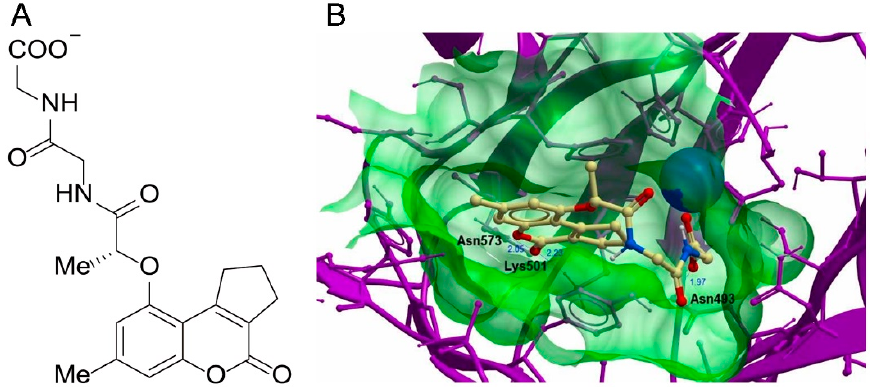
Figure 3. Minimized pose of 1 by in silico docking. ( A ) Molecule structure of compound 1 . ( B ) Protein KDM5A was displayed in the ribbon form. Compound 1 is depicted as a ball-and-stick model showing carbon (yellow), hydrogen (grey), oxygen (red) and nitrogen (blue) atoms. H-bonds are indicated as blue lines and the metal center as a green sphere. The binding pocket of the KDM5A is represented as a translucent green surface.